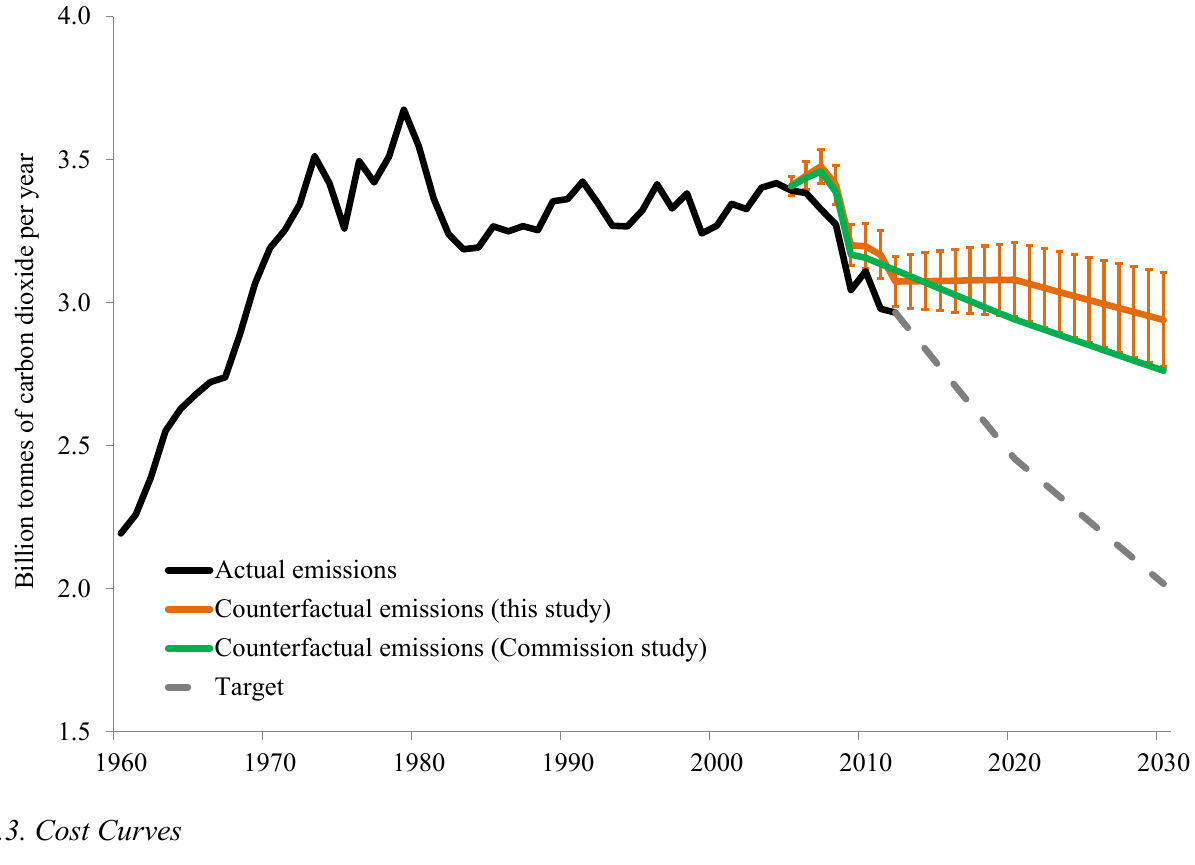
Figure 1. Actual emissions of carbon dioxide from fossil fuel combustion and cement production in Western Europe, emission targets and counterfactual emissions (with its 95% confidence